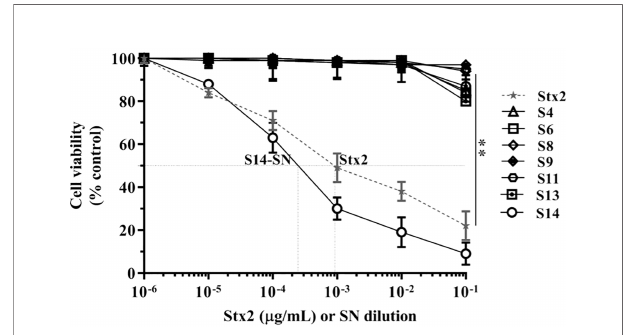
FIGURE 1 | Cytotoxicity of E. coli -positive endocervical samples carrying the stx2 gene on the viability of Vero cells. Vero cells were exposed to serial dilutions of bacterial supernatants (SN) from endocervical samples carrying the stx2 gene or different concentrations of puri fi ed Stx2 under growth- arrested conditions. Cell viability was determined by neutral red uptake after 72 h of incubation, and 100% represents cells incubated under identical conditions but without treatment. Data are shown as means ± S.D from at least three independent experiments performed in triplicate. ** p <